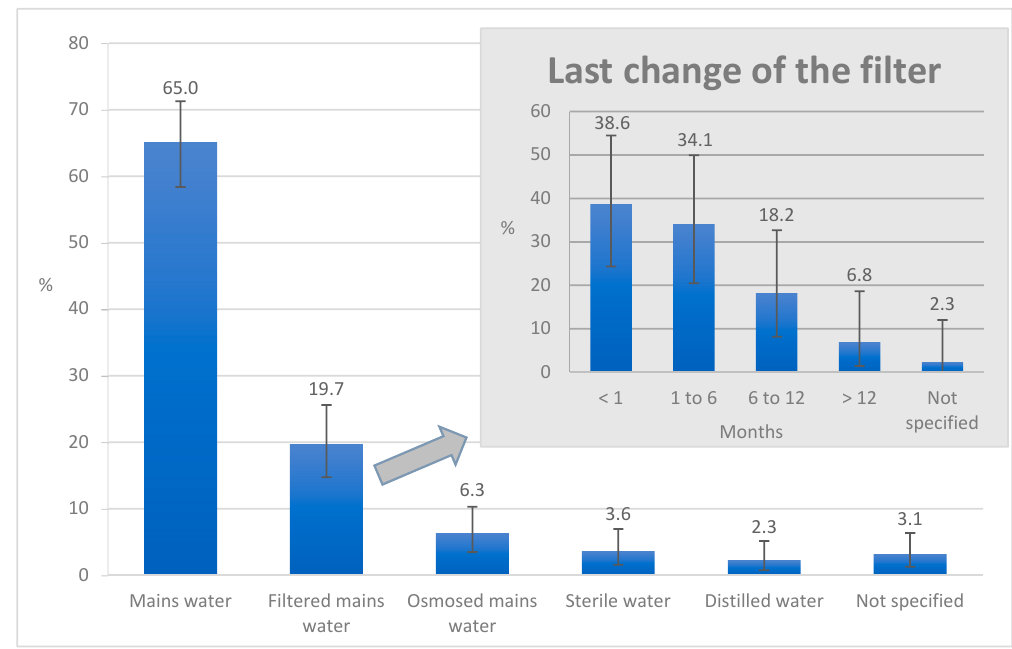
Figure 1. Water supply of the 223 dental care units studied in Eastern France in 2016. Note: Filtered water was passed through a 0.2- µ m filter to remove impurities and bacteria; Osmosed water was purified through a semi-permeable membrane; Sterile water was free of any micro-organisms and toxins in reference to European pharmacopeia; Distilled water was purified after having been boiled into vapor and condensed back into liquid.